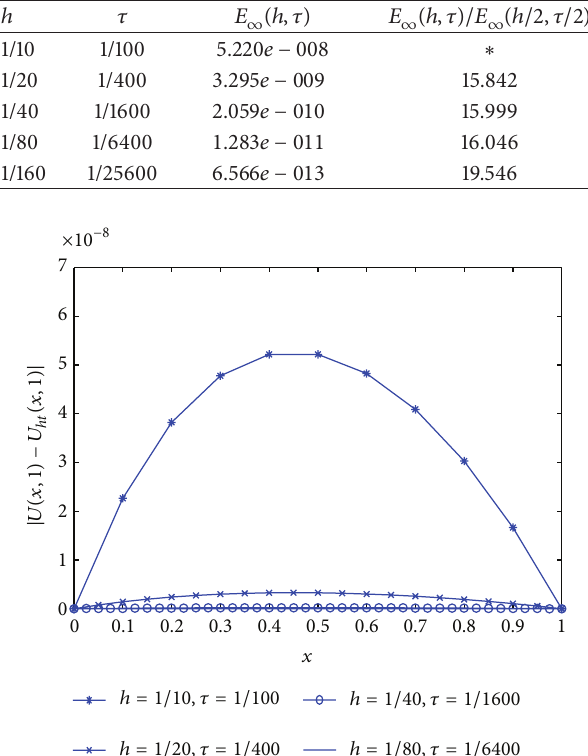
Figure 1: Error curves of difference scheme (20)–(22) solving for problem (54) with different step-sizes when 𝑡 = 1 .